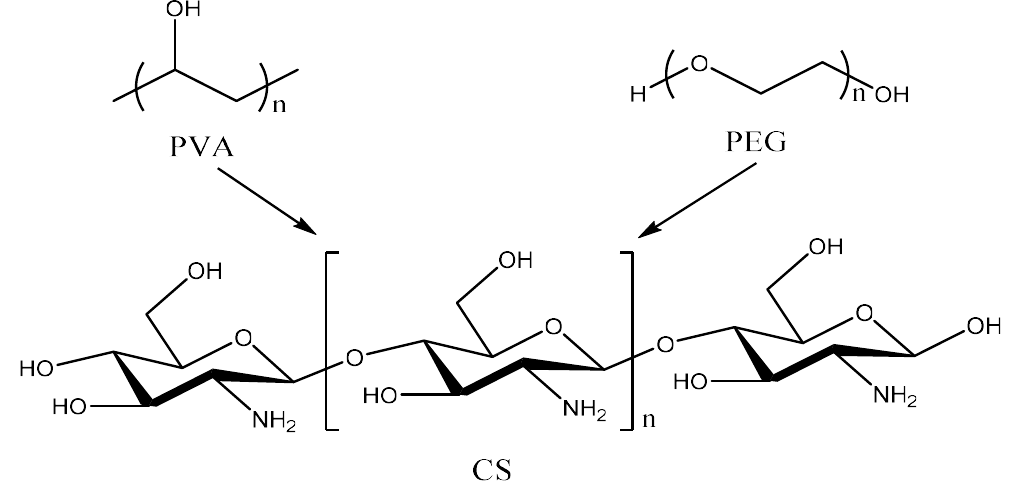
Nanomaterials 2019 , 9 , x FOR PEER REVIEW Figure 4. The figure shows the molecular formulas of PVA, PEG, and CS, respectively.